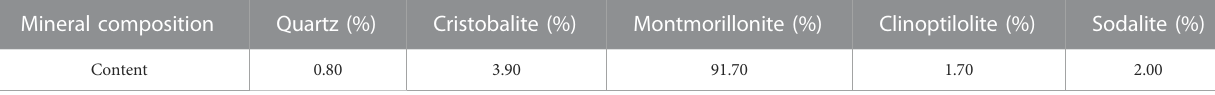
TABLE 1 Compositional information on bentonite tested using an X-ray diffractometer. Mineral